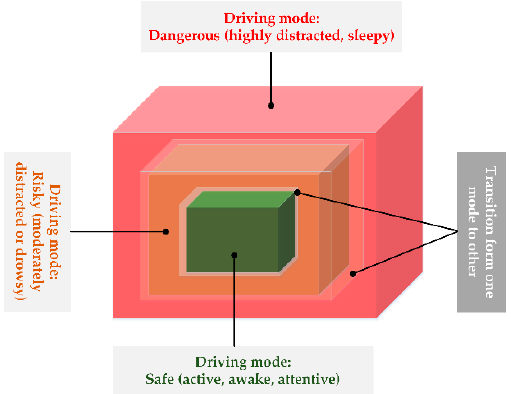
Figure 6. Typical driving modes of a driver and transition stages.